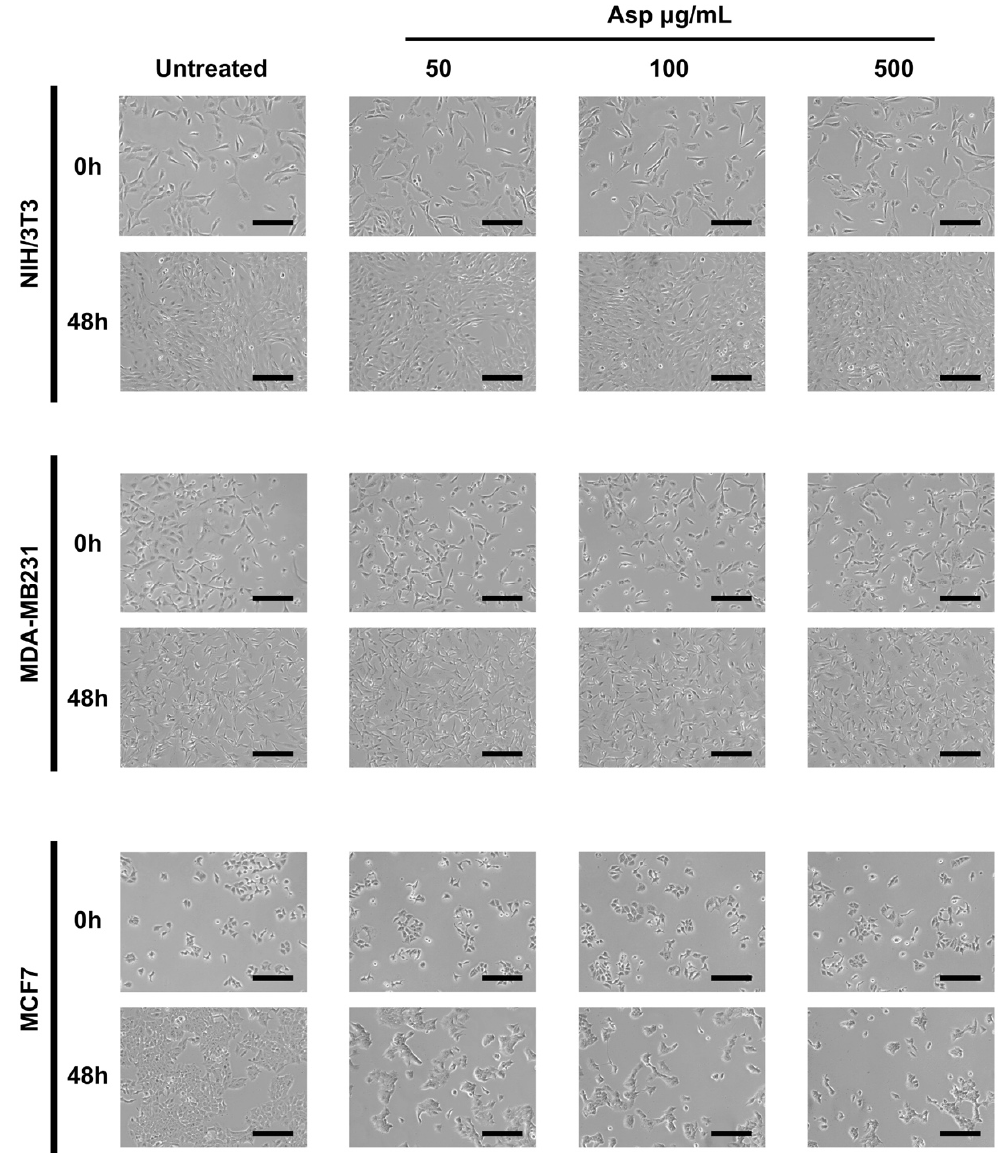
Figure 1. Representative images were taken by light microscopy of NIH/3T3, MDA-MB231 and MCF7 cells untreated or treated with 50, 100, and 500 μ g/mL of Asparagus extracts (Asp) for 48 h. Magnification 10×, scale bar 200 μ m.